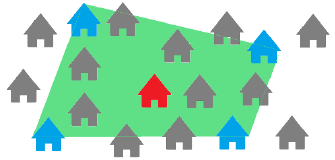
Figure 2. Coverage using